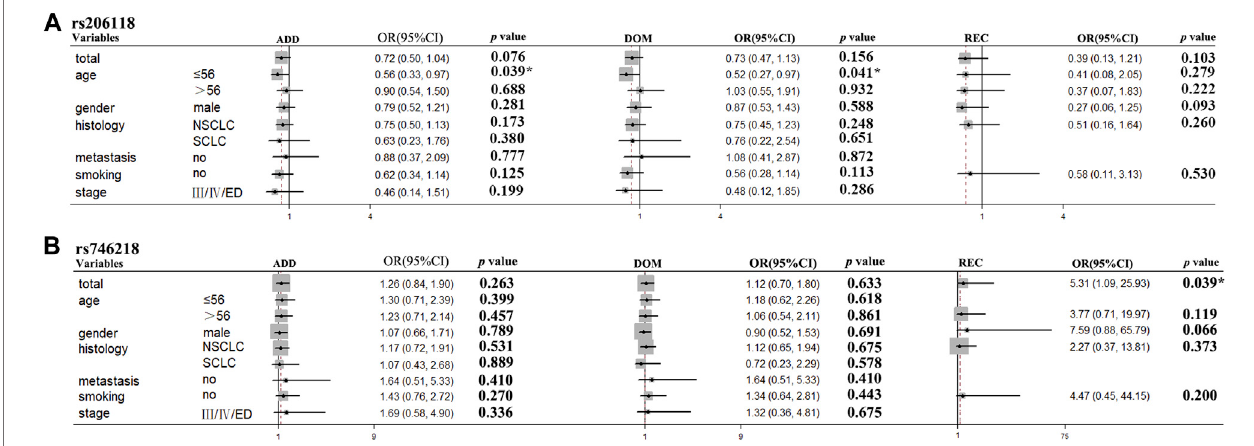
TABLE 6 | Strati fi cation analyses of association between the four polymorphisms and OS in lung cancer patients. Genes SNPs